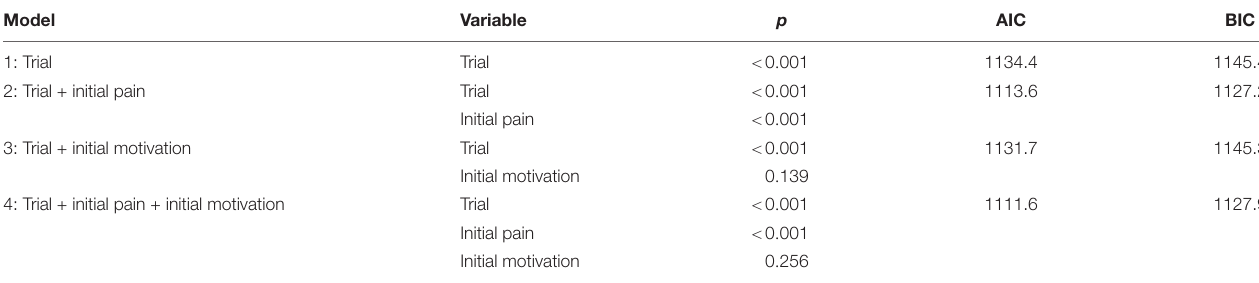
TABLE 3 | Model characteristics examining the factors affecting wall-sit performance time. Model